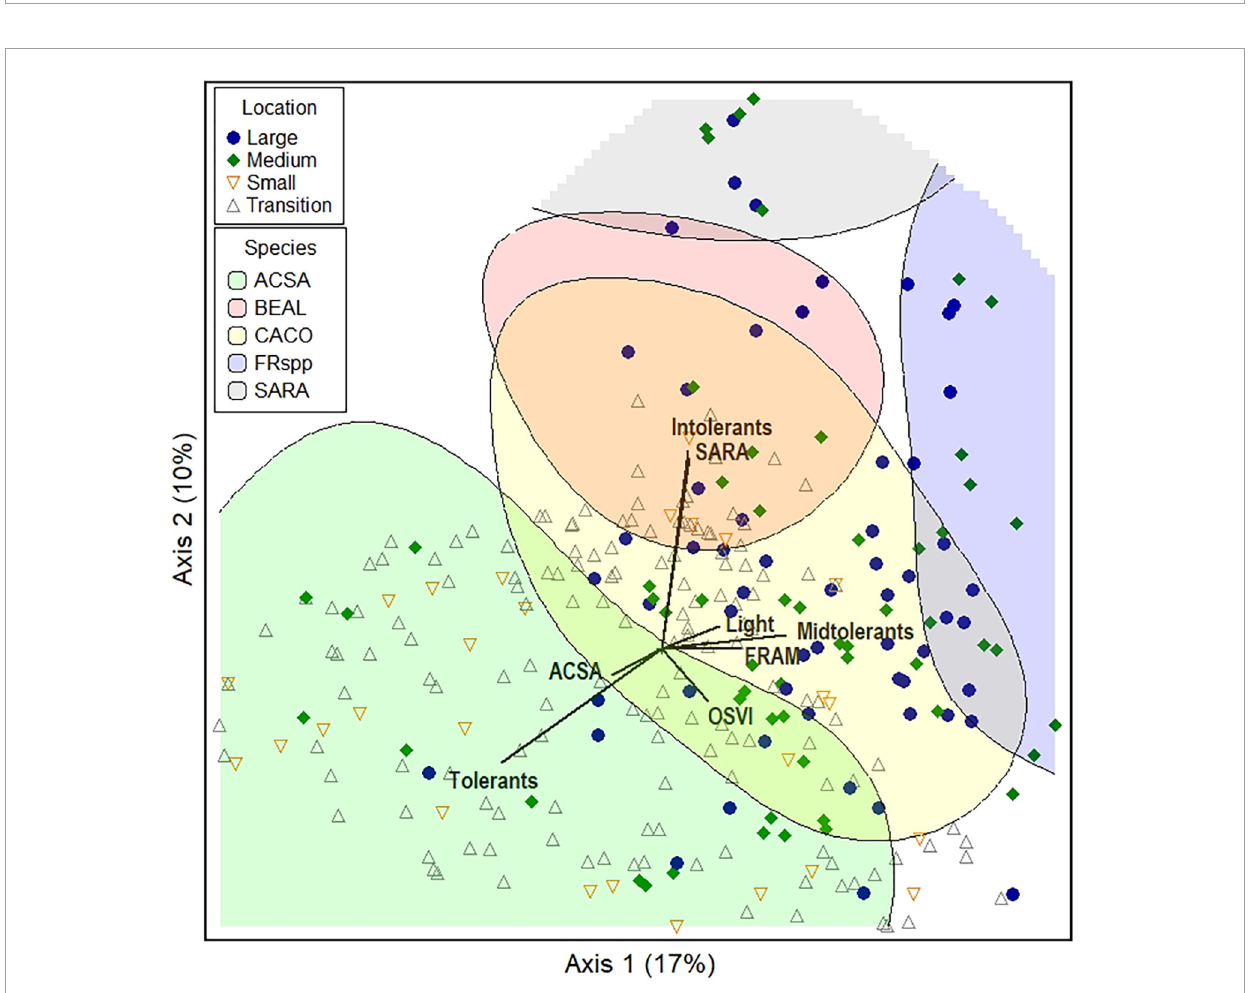
FIGURE3 Bray-Curtis ordination of sapling density in permanent plots measured 9 years post-harvest. Species hilltops highlight the upper 20% of plots where these species occur. Vectors indicate association of specific species or tolerance groupings with particular plots. Light availability was modeled (section “2.1. Study